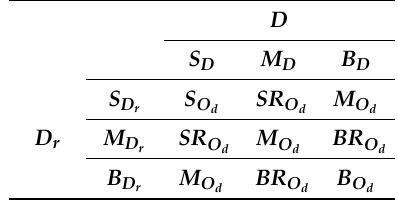
Table 2. Inference rules of fuzzy inference system ( FIS α ) on the angle of adjacent vectors.